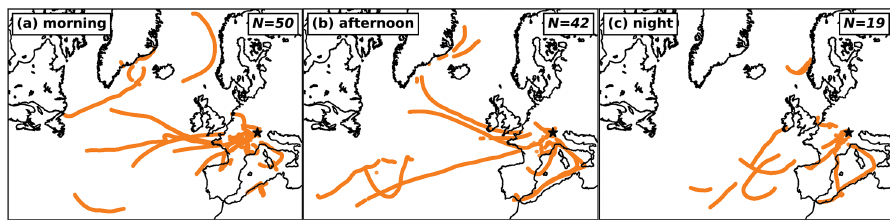
Figure A3. Footprint map calculated from back trajectories of each sample taken at WFJ for the periods in the morning (a) , afternoon (b) , and at night (c) , as defined in Sect. 2.1.1. The dots indicate places where the trajectories were lower than 500m above ground. The number of trajectories per plot ( N ) is listed in the upper right corner of each plot. The black star indicates the location of